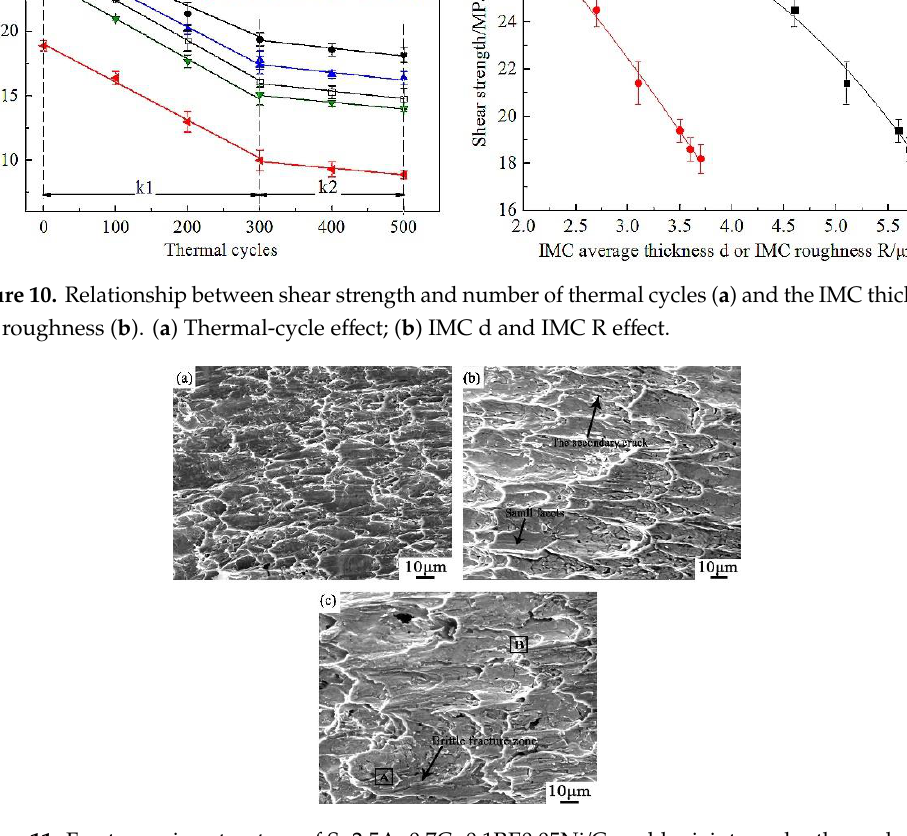
Figure 11. Fracture microstructure of Sn2.5Ag0.7Cu0.1RE0.05Ni/Cu solder joints under thermal cycles. ( a ) 100 cycles; ( b ) 300 cycles; ( c ) 500 cycles.